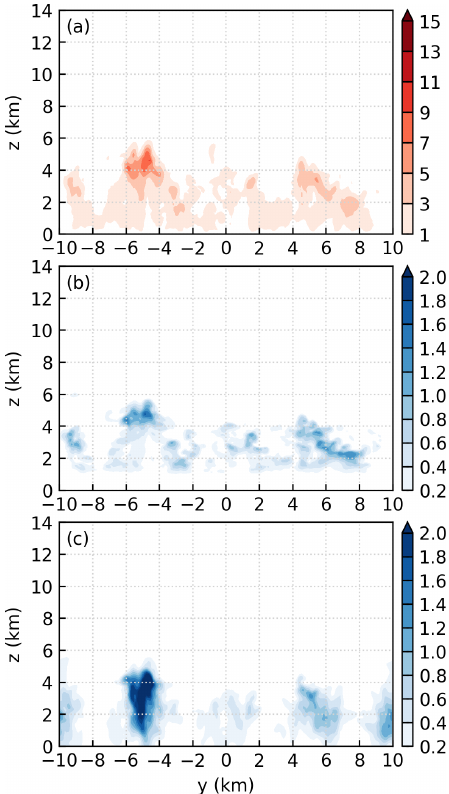
Figure 10. (a) Vertical velocity (ms − 1 ) , (b) cloud water mixing ratio (gkg − 1 ), and (c) rain water mixing ratio (gkg − 1 ) averaged from x = − 2 to 2km at t = 7h 56min in simulation